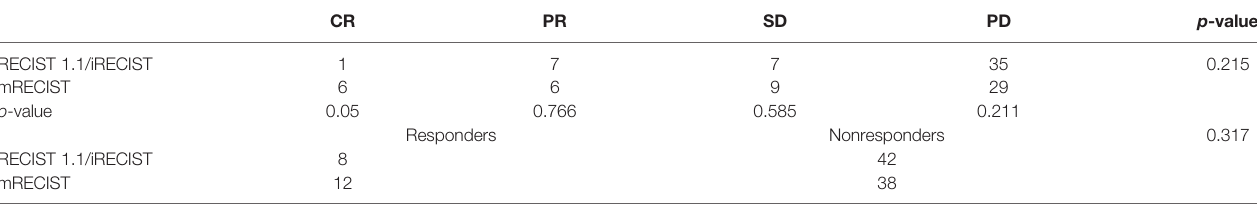
TABLE 3 | The results of univariable analysis comparing RECIST 1.1, iRECIST, and mRECIST